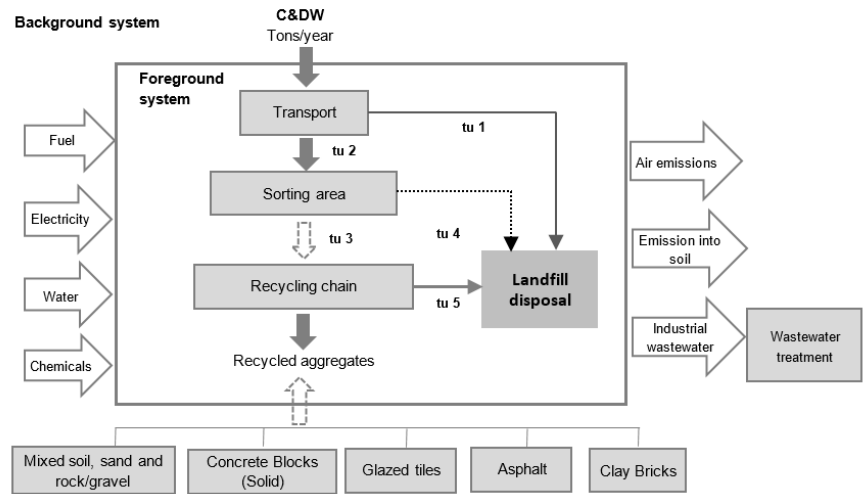
Figure 2. System boundaries for the municipal CDW management systems considered in this study, with the indication of the foreground and background systems. Dashed lines refer to the streams that have differences among the management systems analyzed. The transport stages are indicated by the acronym “tu” (transport unit).